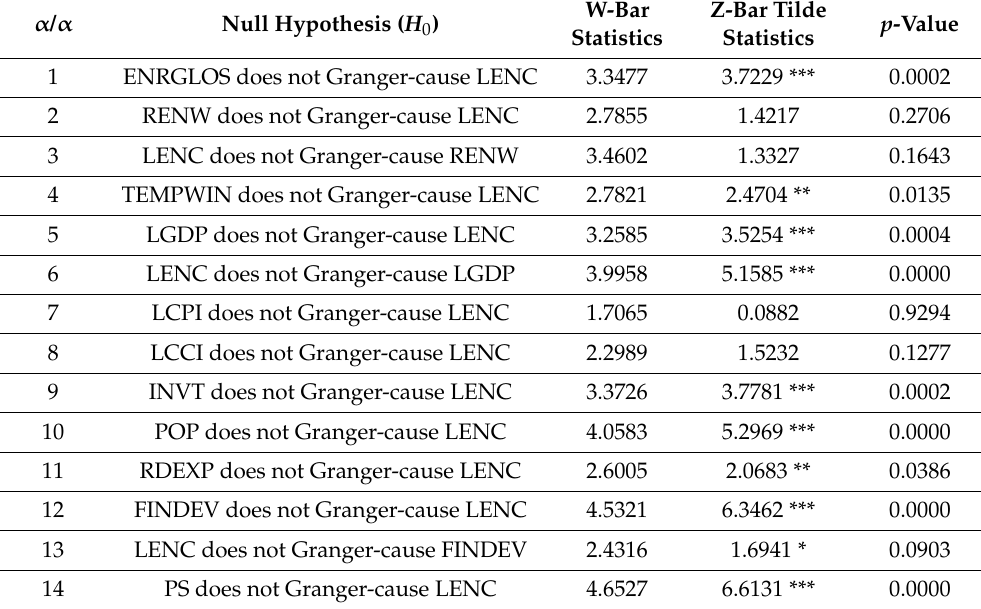
Table 8. Results of Granger Causality tests as Dumitrescu and Hurlin [26] performed. α /